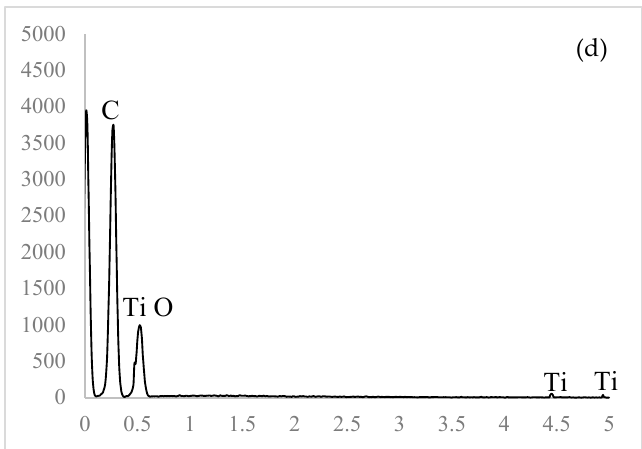
Figure 3. FE-SEM micrographs of the EC films. ( a ) Surface of film. ( b ) Cross-section of film. ( c ) TiO 2 deposition inside EC film. ( d ) EDS analysis of the 10% EC(EtOH)TiO 2 film.